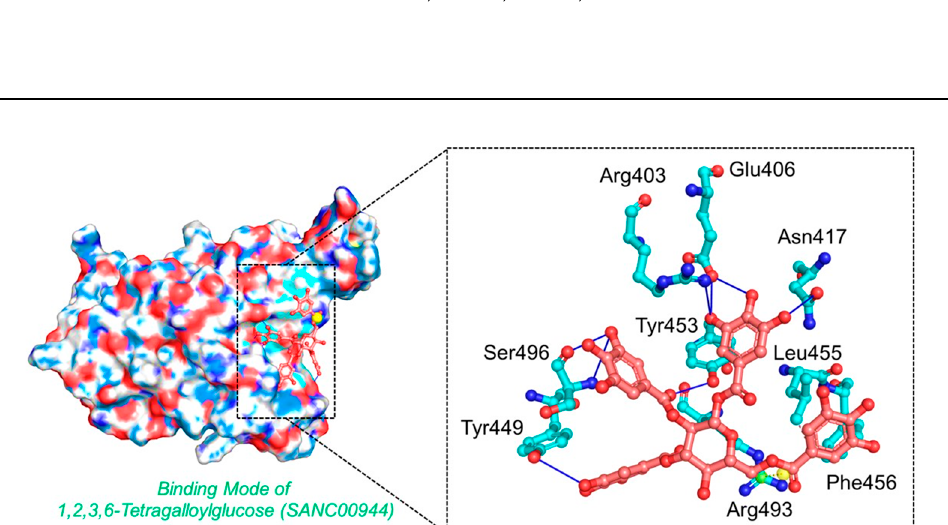
Figure 3. The interaction pattern of 1,2,3,6-Tetragalloylglucose (SANC00944). The left panel shows the surface representation and the binding conformation of 1,2,3,6-Tetragalloylglucose (SANC00944), while the right panel show the 3-dimensional interaction